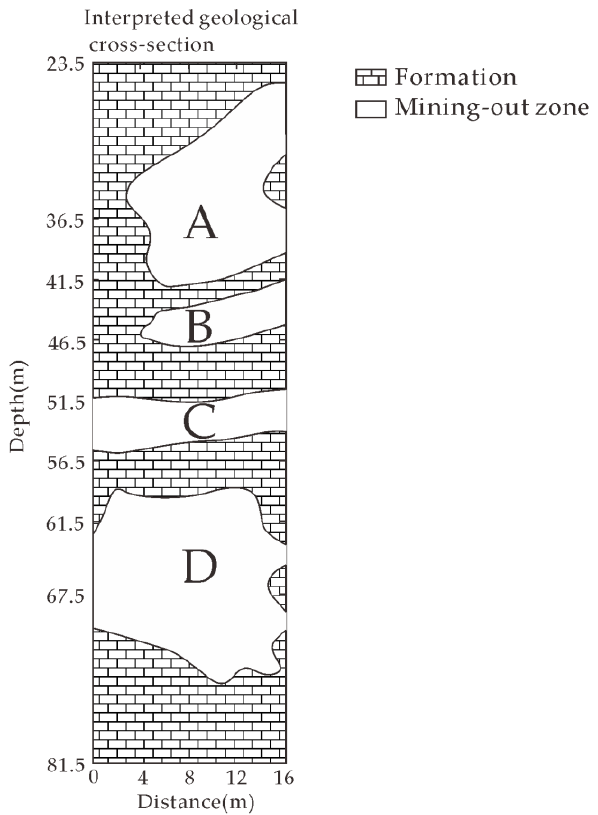
Figure 11. Interpreted geological cross-section from inverted results between two boreholes.